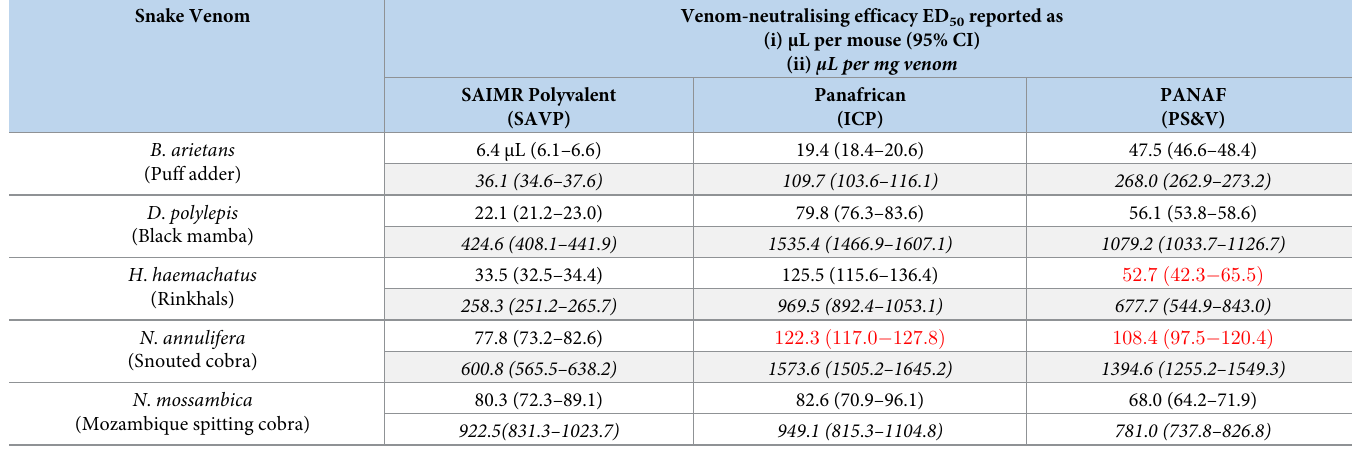
Table 3. The preclinical venom-neutralising efficacy (antivenom ED 50 ) of the PANAF (PS&V) and Panafrican (ICP) antivenoms compared to SAIMR Polyvalent in the pre-incubation model of envenoming. ED 50 is defined as the volume of antivenom which protects 50% of mice from the lethal effects of venom. Each experiment used five mice per dose group. The assays utilised a venom challenge dose of 5 x venom LD 50 s (Table 2), except when it was necessary to reduce the challenge dose 3 x venom LD 50 s (indicated by red text). In these instances, the maximum volume limit of antivenom that can be injected intravenously was reached without reducing the venom lethality of the 5 x LD 50 venom dose, therefore it was necessary to reduce the venom dose to determine an ED 50 for the antivenom. Results are reported as ED 50 determined by Probit analyses and expressed in (i) volume of antivenom and, in italics, (ii) as μ L of antivenom per mg of venom. 95% confidence intervals are reported in parentheses. Snake